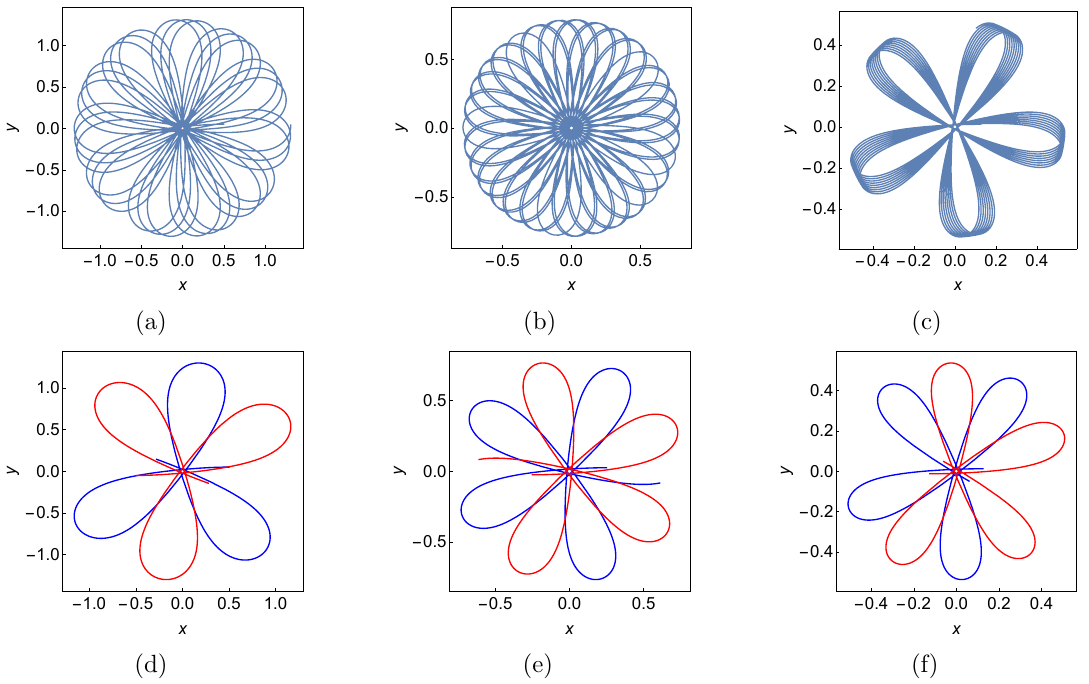
Figure 5 . Three examples of bound states for µ = M P = 1 . (a) shows the trajectory in the reduced coordinate ~r (2.4) for t = 100 , and (d) shows the trajectories for the two particles with t f In both cases ω = 5 , a = 1 , and b = 0 . 1 . (b) shows the trajectory in the reduced coordinate ~r for t f = 100 , and (e) for t f = 8 . Here ω = 10 , a = 0 . 5 , and b = 0 . 05 . (c) Trajectory in the reduced coordinate ~r for t = 50 , and (f) for t = 5 . Here ω = 20 , a = 0 . 25 , and b = 0 . 025 . In blue, we f f displayed the trajectory of the particle of radial vector ~r , while in red, we displayed the particle 1 with radial vector ~r = − ~r 2 1